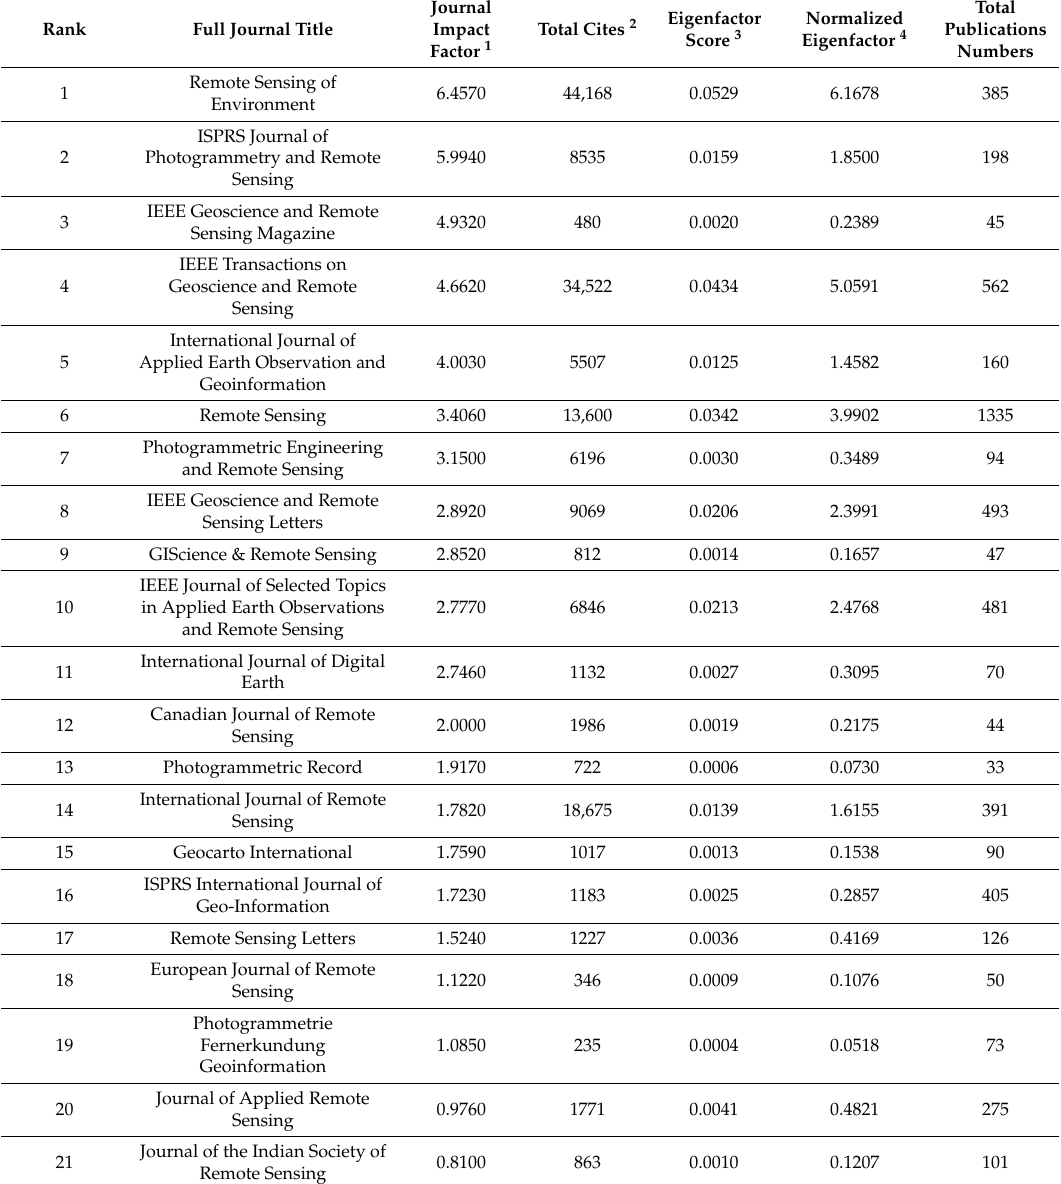
Table 1. Comparison of various journals that publish remote sensing science and technology extensively for the year